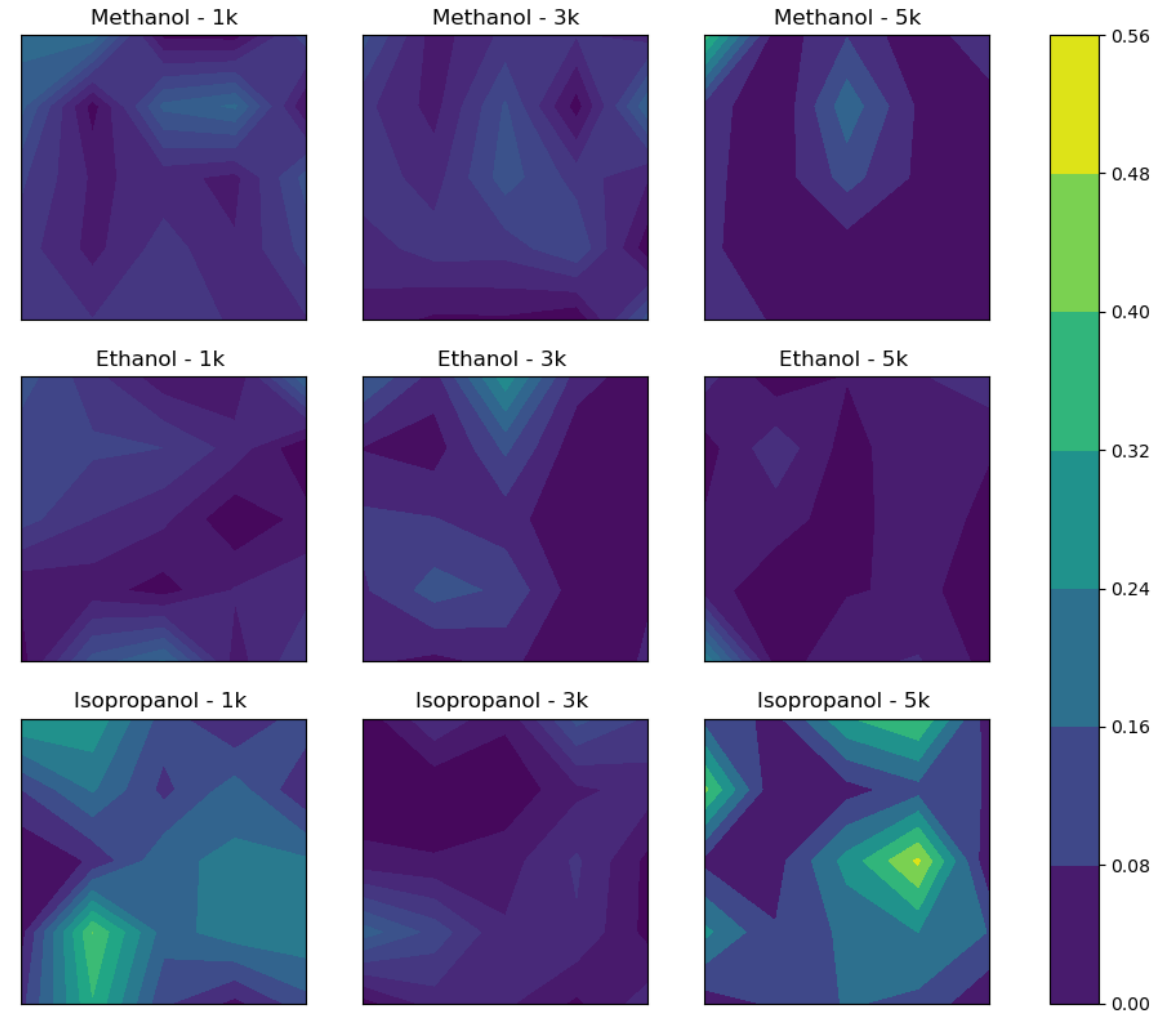
Figure 5. Contour plots constructed from the measurements made on films developed by 100% solvent additions at the specified RPM. A selected data set from Figure 4.